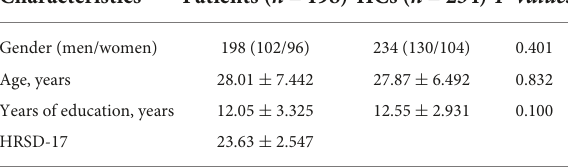
TABLE 1 Demographic and clinical